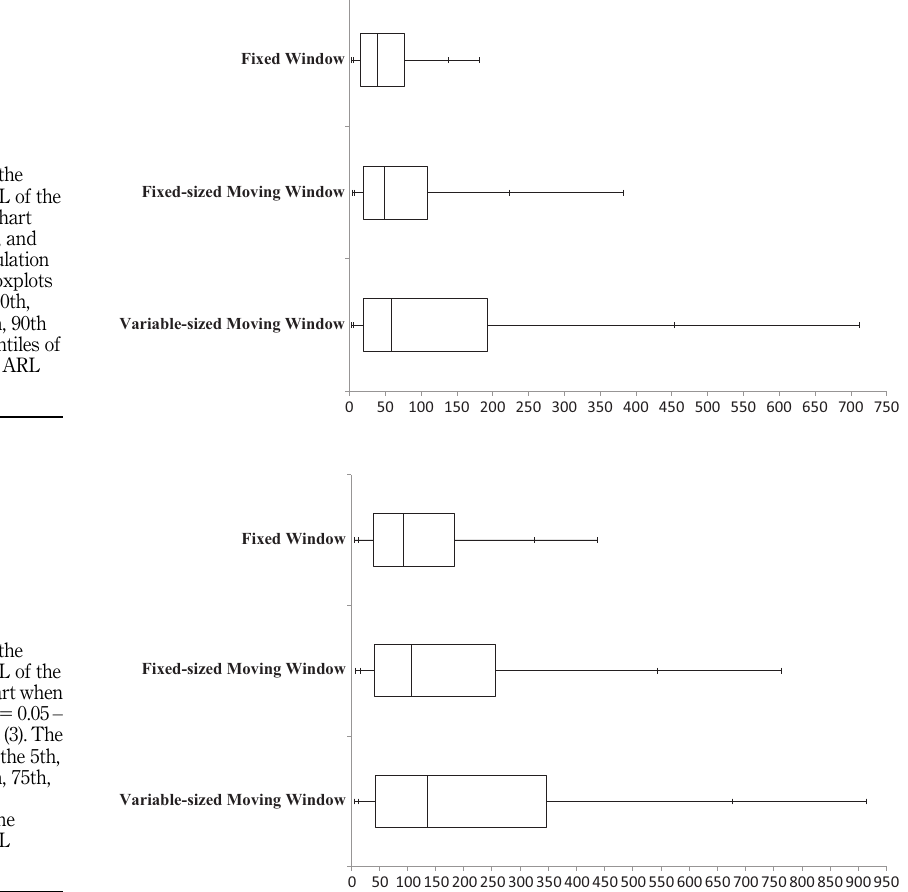
Figure 1. Out-of-control distribution of the conditional ARL of the Shewhart P 11 -chart when m 5 500, and e 5 0.01 – simulation case (2). The boxplots